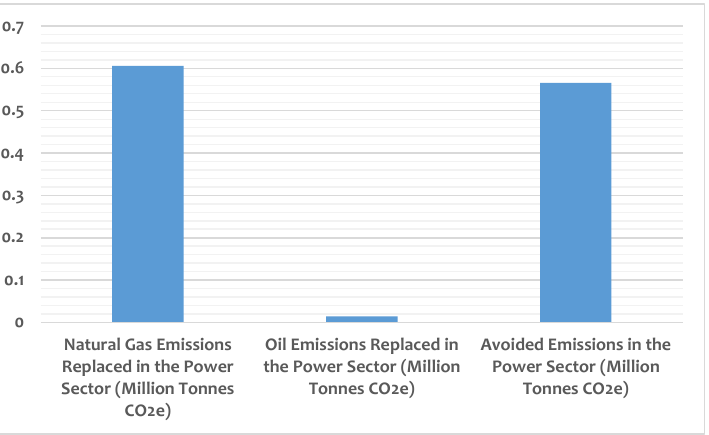
Figure 8. Avoided emissions of solar energy for the UAE (2018). Data were collected from [52].